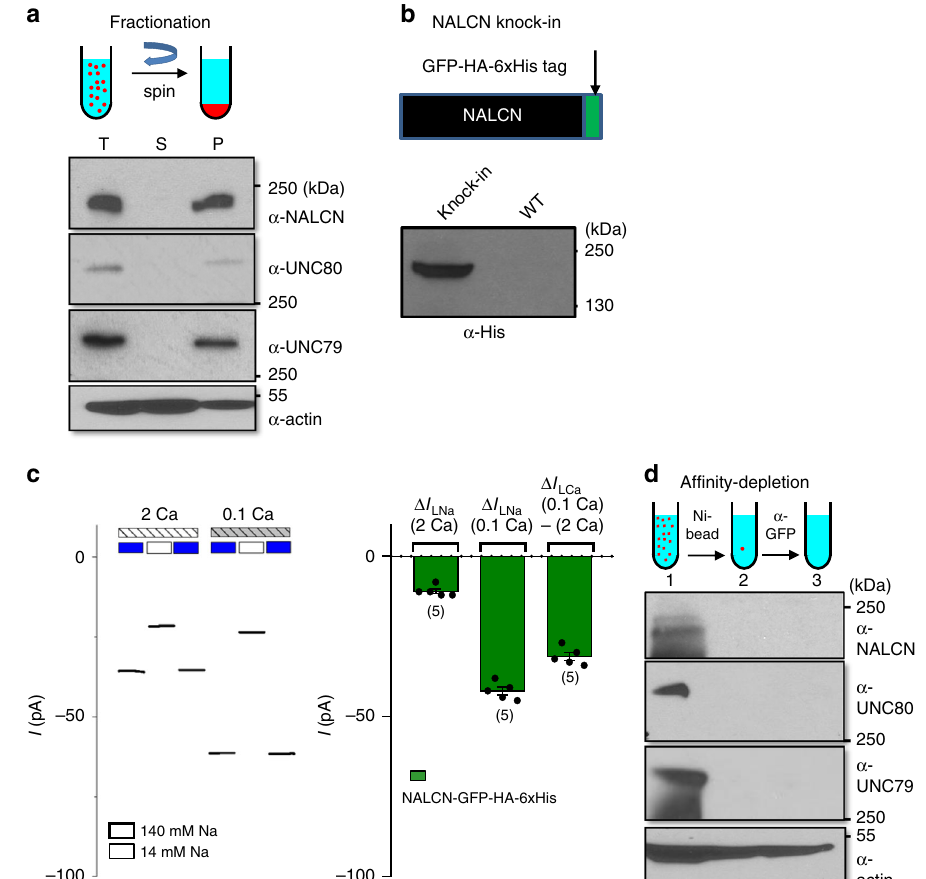
Fig. 4 UNC80 and UNC79 are auxiliary subunits of the NALCN channel complex. a Protein fractionation demonstrating that UNC80 and UNC79 co- segregate with NALCN to the membrane fraction. Total proteins (T) from adult brains were centrifuged at 200,000 × g and separated into the cytosolic (supernatant, S) and microsomal membrane (pellet, P) fractions, as illustrated in the schematic diagram (upper). Each fraction was blotted with anti- NALCN, anti-UNC80, anti-UNC79, or anti-actin antibody. b A knock-in mouse line with NALCN tagged with GFP, HA, and His tags (NALCN-GFP-HA-His mice). Upper, schematic design. Lower, total brain proteins (100 μ g) prepared from the triple-tagged mice and wild-type (non-tagged) mice were immunoblotted with anti-His antibody. c TTX-resistant Na + leak currents recorded from neurons cultured from the KI pups ( n = 5). Left, representative current traces. Right, averaged current amplitudes. Recordings were from − 70 mV and were done with bath solutions with varying [Na + ] (140mM or 14 mM) and [Ca 2 + ] (2 mM (2 Ca) or 0.1 mM (0.1 Ca)) (see Fig. 2 legend for details). Numbers of neurons recorded are in parentheses. d Protein depletion demonstrating that all UNC80 and UNC79 proteins are associated with NALCN. Total brain protein lysates were prepared from the NALCN-GFP-HA-His mice. NALCN was depleted by incubating with Ni column (binding to 6-His) followed by further immune depletion with anti-GFP antibody. Lysates before (lane 1) and after (lane 2: with Ni-beads, lane 3: with α -GFP agarose) depletion were blotted with anti-NALCN, anti-UNC79, or anti-UNC80 antibody. Anti- actin was used as a control. For ( a , b , d ), three or more independent repeats were performed with similar results. Data are presented as mean values ± SEM. Source data are provided as a Source Data fi